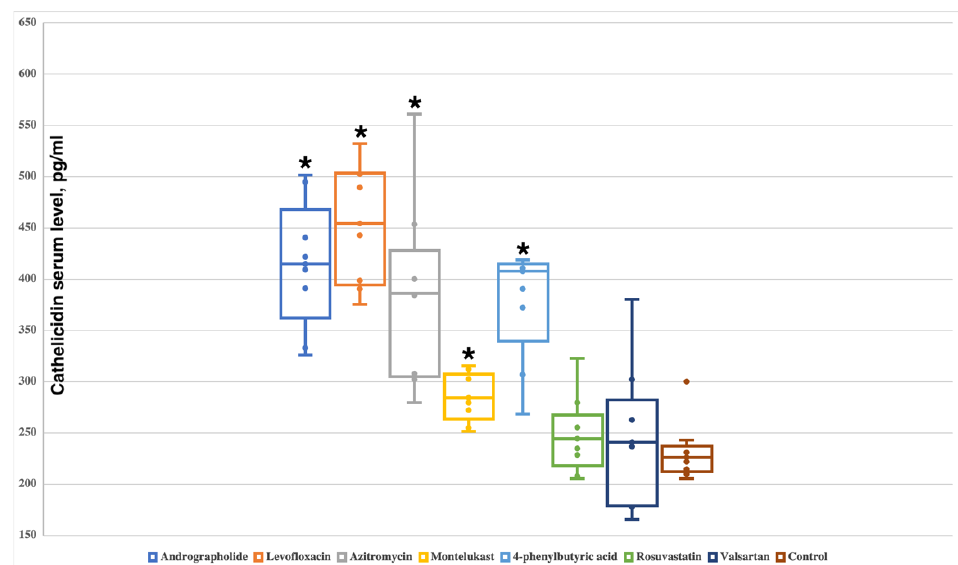
Figure 3. The effect of administration of the studied small molecules on the level of cathelicidin in rats. Boxplots show median, lower and upper quartiles, minimum and maximum, and individual data points. Significant differences from the control group are marked with an asterisk.